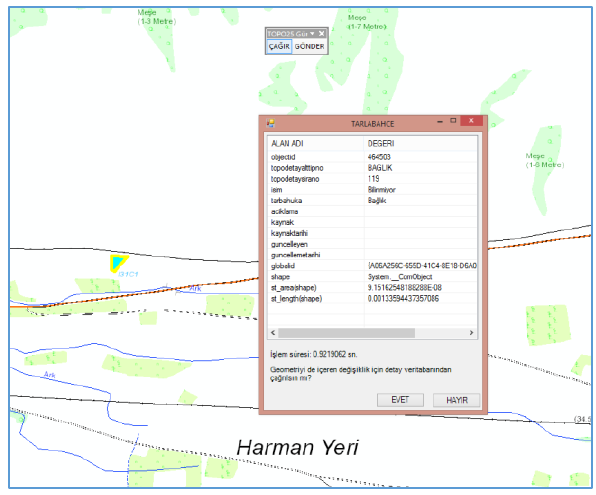
Figure 7. Displaying single feature’s attributes